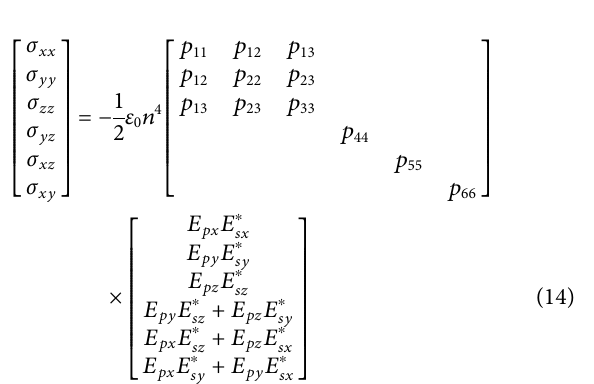
FIGURE 4 | (A) Plot showing the Brillouin gain as a function of frequency with the waveguide width set to w = 800 nm; the red line represents the MB effect, the orange line the PE effect, and the blue line the total gain. (B) Calculated FSBS gain coef fi cients as the width of the air slot s is varied.